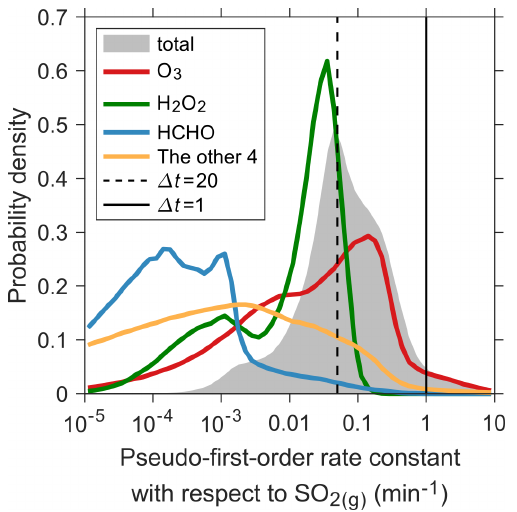
Figure 3. Probability density distributions of the pseudo-first-order rate constants with respect to SO 2 ( g ) for cloud reactions in the con- trol simulation. The shaded area shows the sum of rate constants for the seven reactions consuming SO 2 . The red, green, blue, and or- ange curves indicate the distributions for reactions with O 3 , H 2 O 2 , HCHO, and the sum of rate constants for the other four reactions consuming SO 2 (TMI + O 2 , NO 2 , HONO, and HOBr), respectively. Data shown are for the first week of July and in the lower tropo- sphere (13 vertical layers above surface up to about 800hPa). Since the chemistry time step ( (cid:49)t) of this simulation is 20min, there are 504 steps in this week. The total number of data points is 72 × 46 (number of 5 ◦ × 4 ◦ grids) × 13 (vertical layers) × 504 ≈ 2 . 2 × 10 7 . About 1.4 × 10 7 data points have aqueous clouds (cloud fraction f c > 0), accounting for about 2 / 3. The probability density distribu- tions are plotted based on these data points. The dashed and solid vertical black lines indicate the rate constants corresponding to (cid:49)t of 20 and 1min,